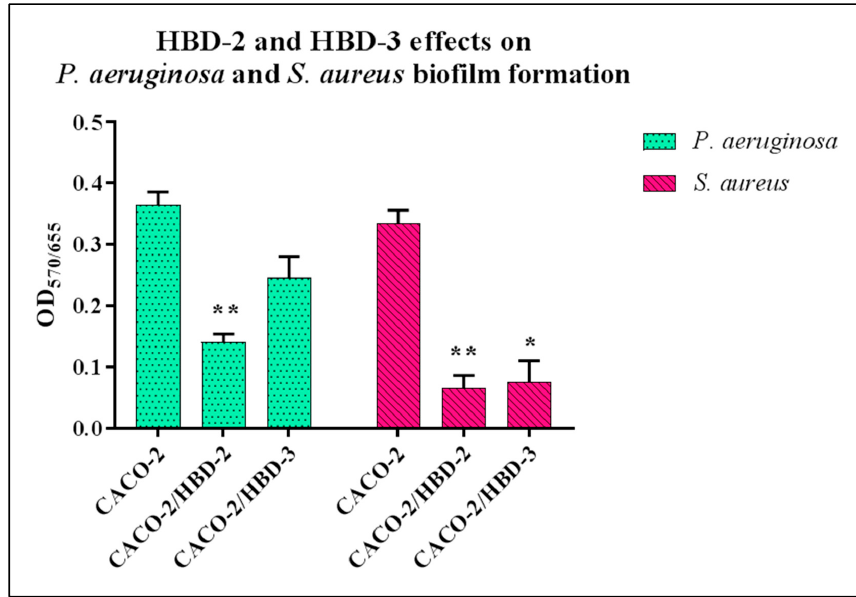
Figure 1. Evaluation of biofilm formation in P. aeruginosa and S. aureus re-suspended in conditioned media of Caco-2, Caco-2/HBD-2 and Caco-2/HBD-3 by crystal violet staining. Data are representative of three different experiments ± SD. Significant differences are indicated by * p < 0.05, ** p <